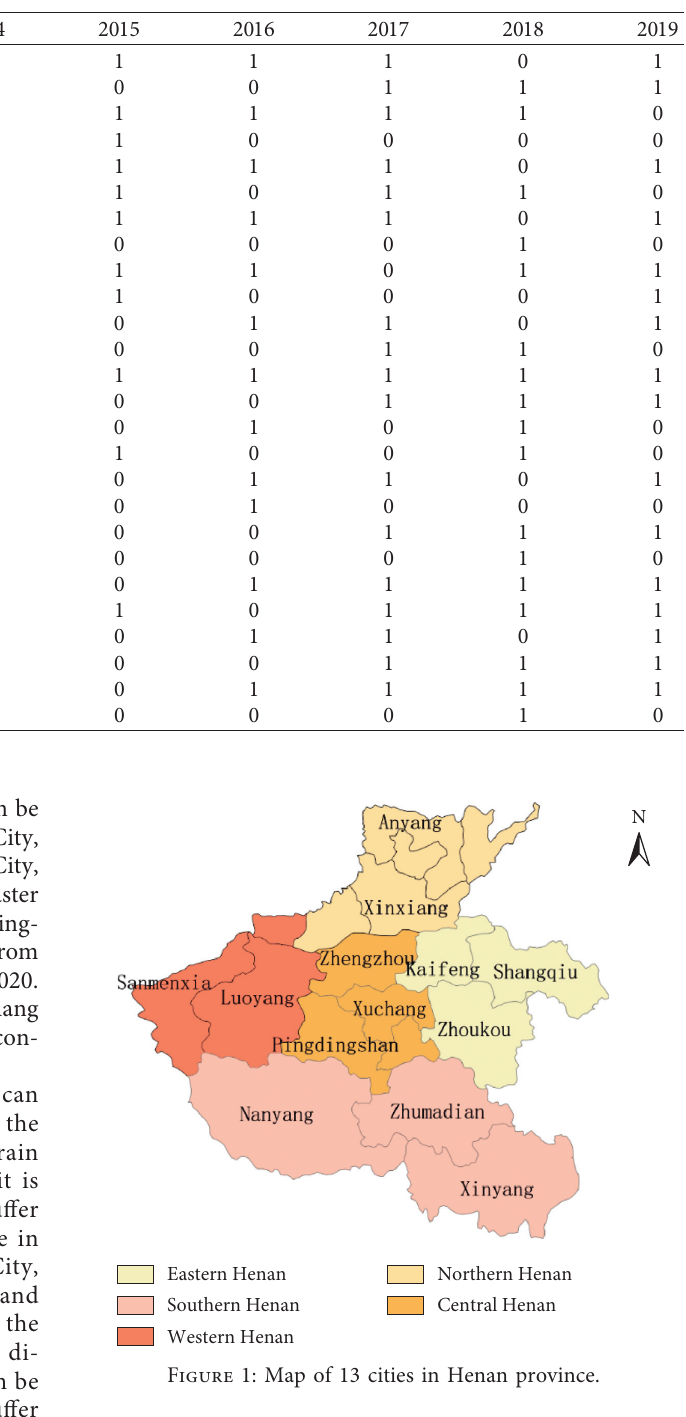
Table 1: The occurrence of continuous rain disasters in 13 cities of Henan province.